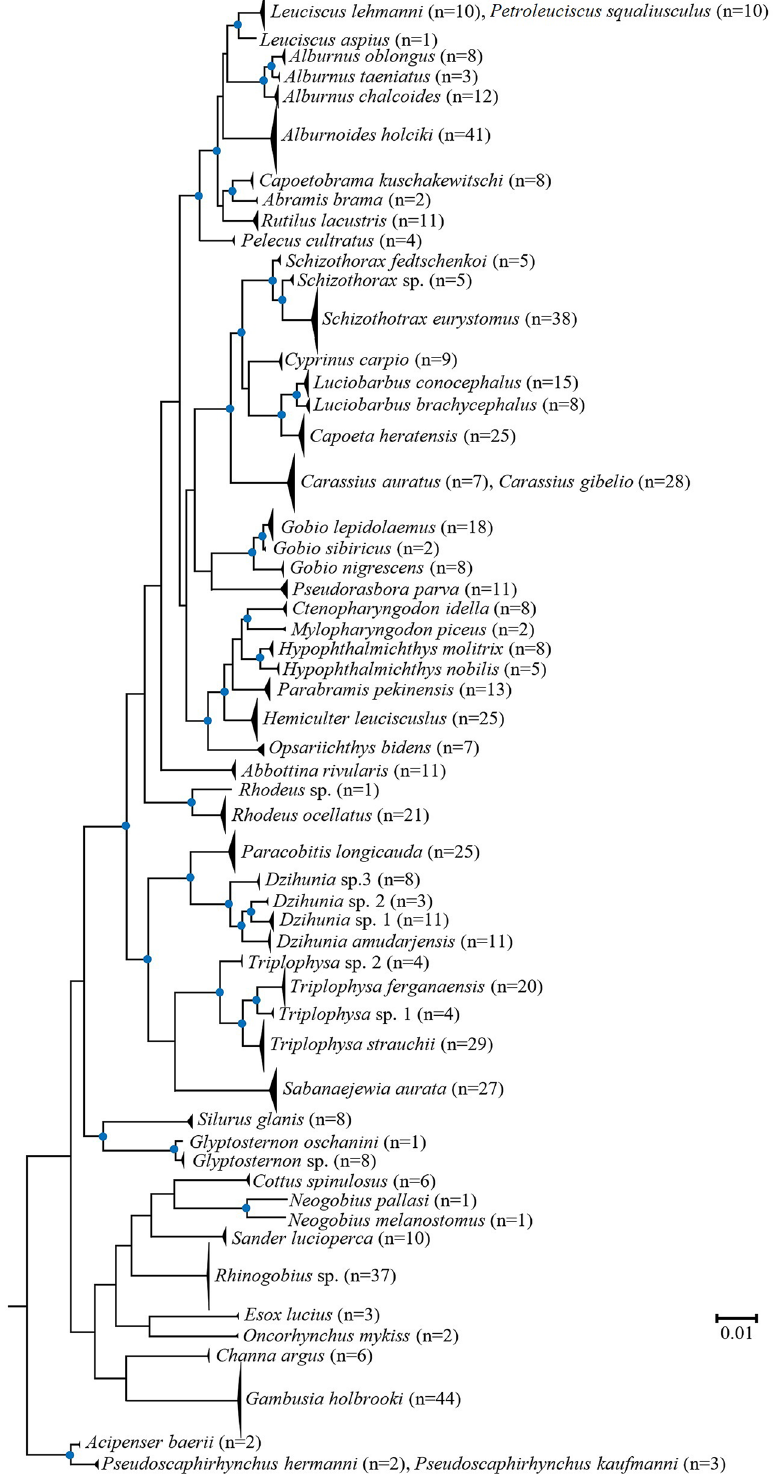
Figure 3. Bayesian inference (BI) consensus tree based on the COI partial gene sequences. The blue circle at nodes represents BI posterior probabilities values > 50%. Posterior probability values for all species are >